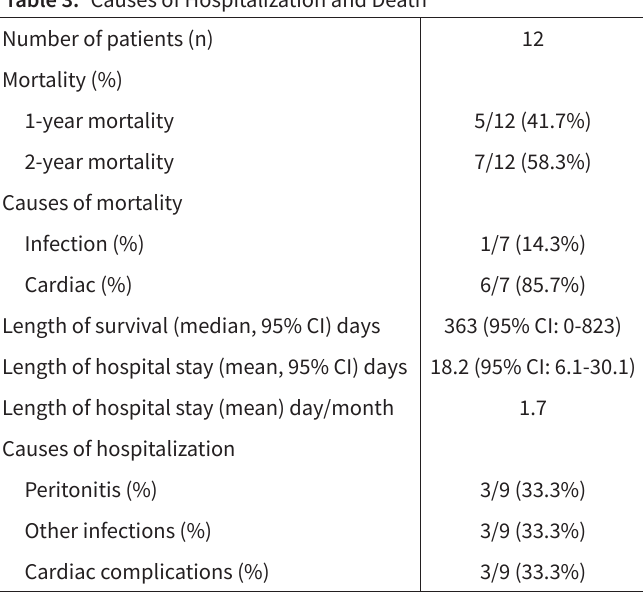
Table 3. Causes of Hospitalization and Death